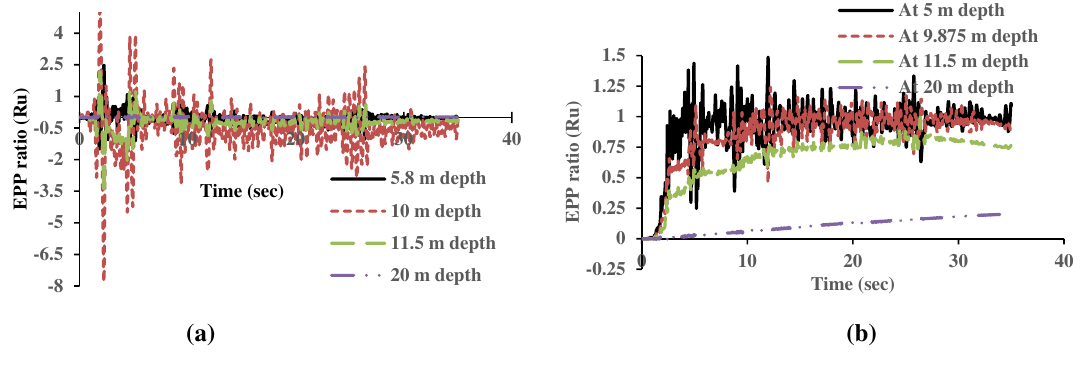
Fig. 11 Comparison of time history of R